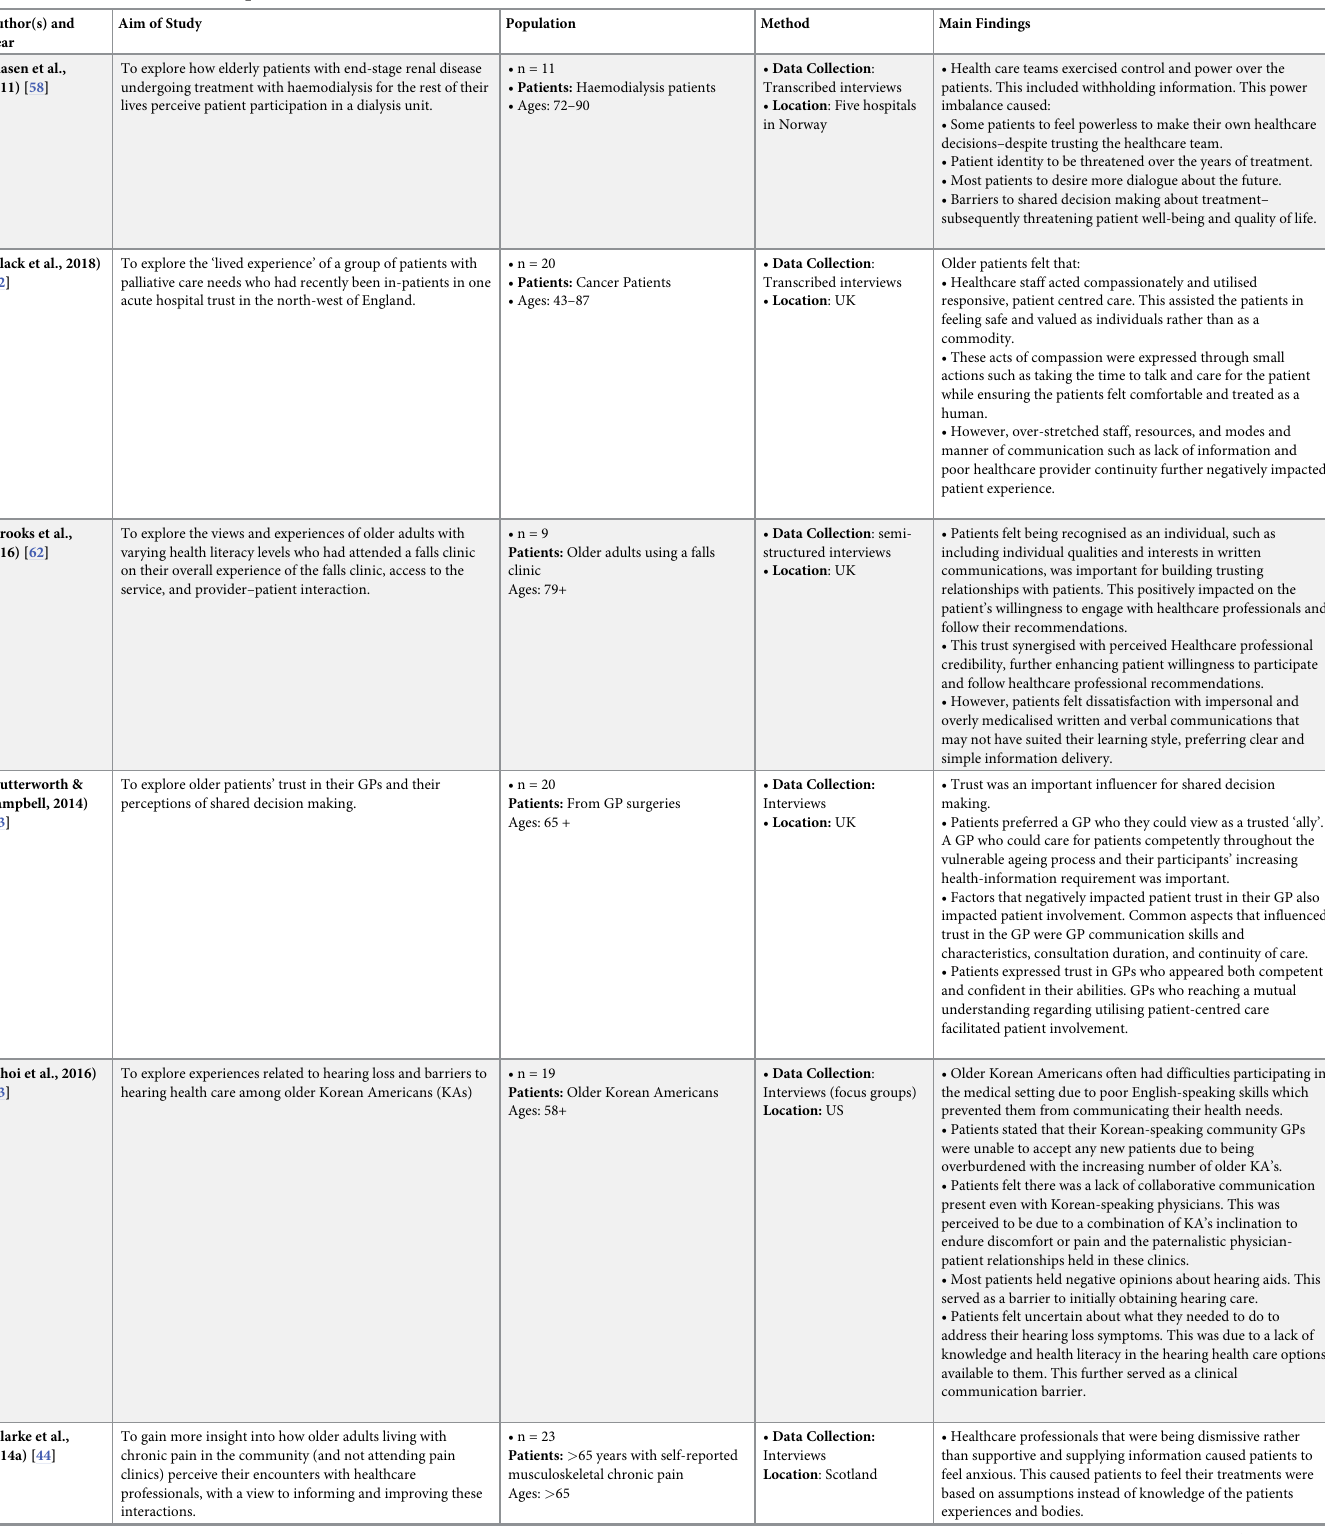
Table 3. Characteristics of the qualitative